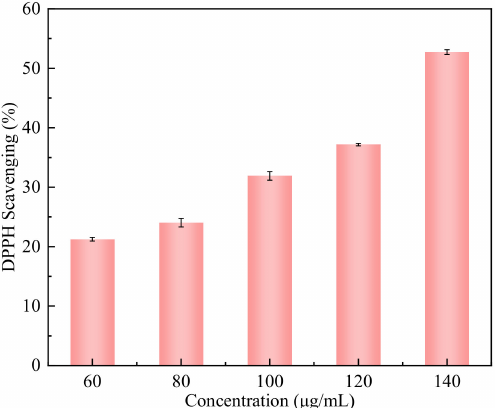
Figure 12. DPPH-scavenging rates of CA-loaded composite nanoparticles with different mass con-